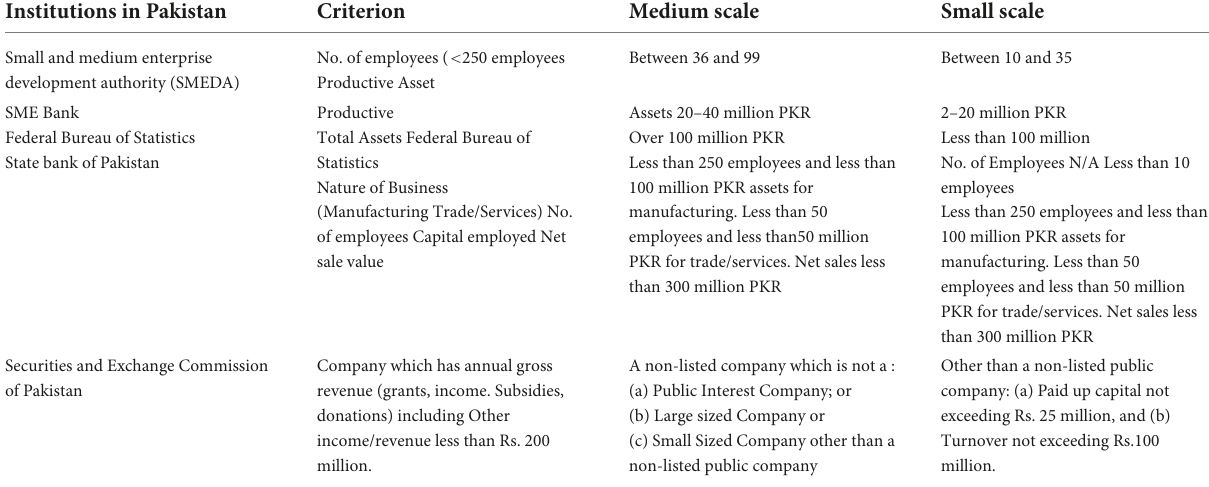
TABLE 3 Small and medium-sized enterprises definition in